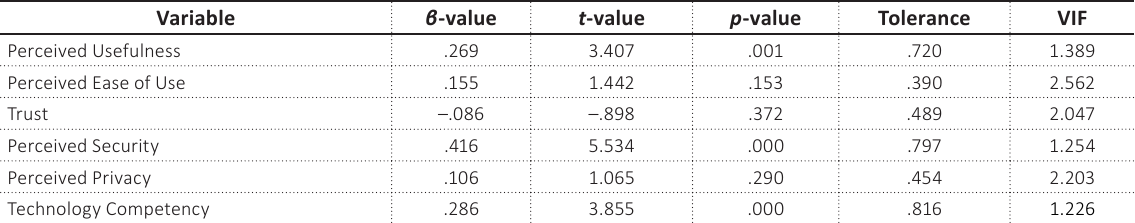
Table 4. Results of the coefficient value (regression